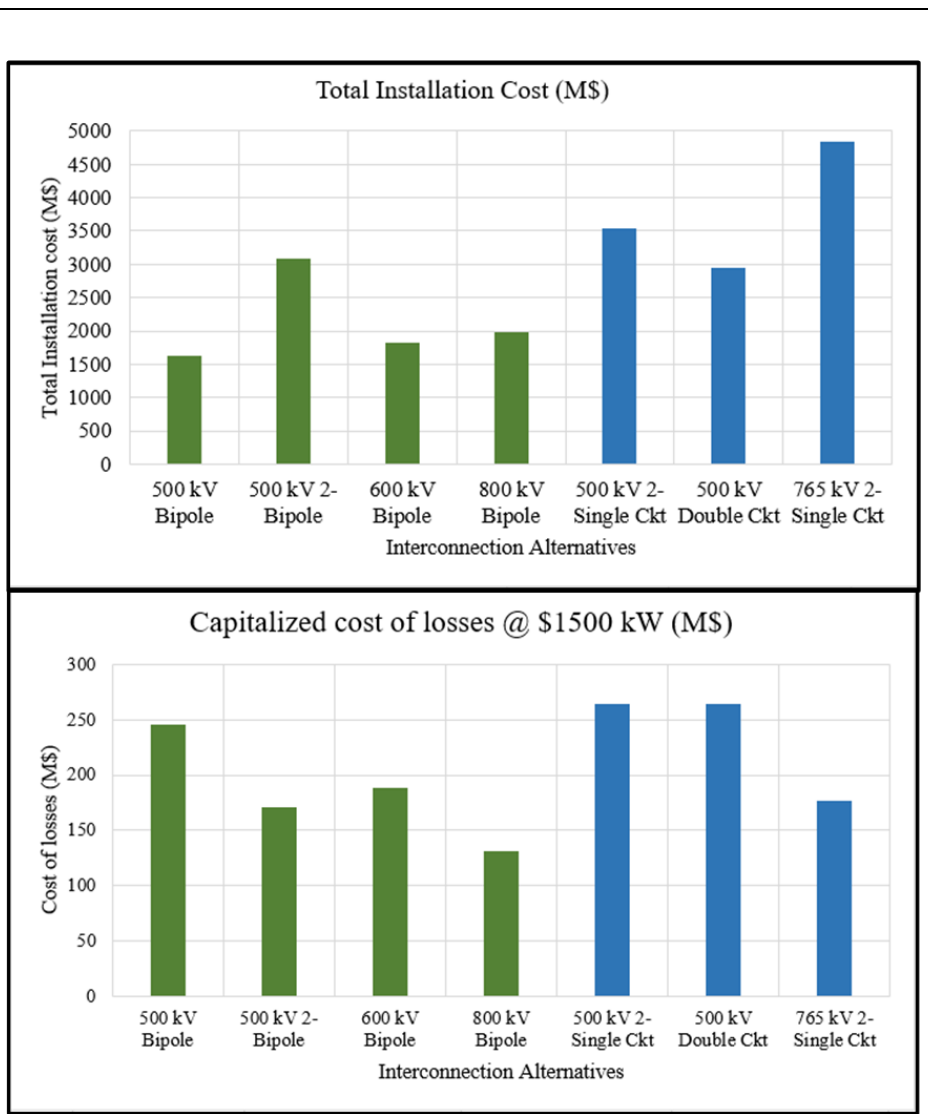
Figure 16. Costs comparison of HVDC and EHV AC transmission systems